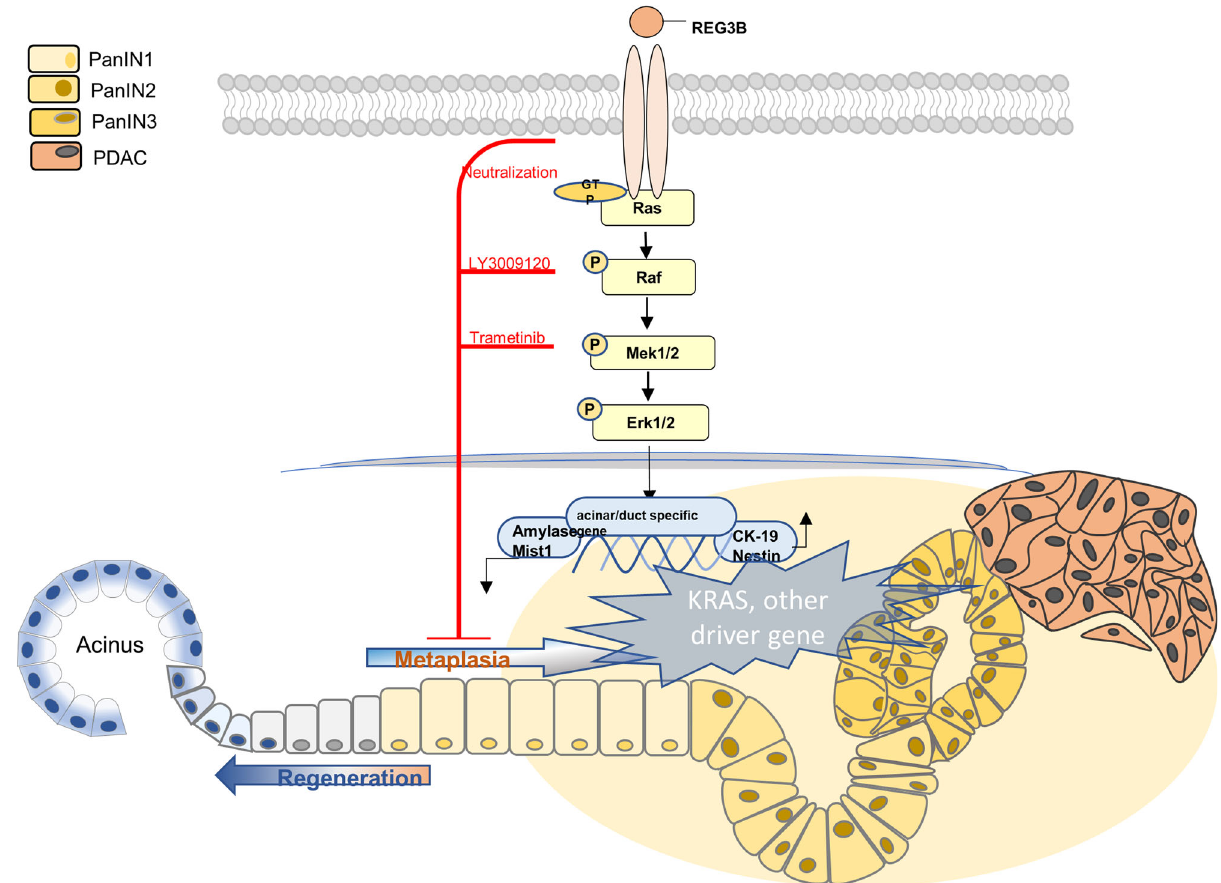
Fig. 8 Schematic illustration of the molecular mechanism of REG3B/REG3A-driven ADM. REG3B/REG3A binds to its receptor, EXTL3 receptor on the acinar cell membrane, and promotes ADM by activating the downstream RAS-RAF-MEK-ERK signaling pathway, in the absence of oncogenic Kras mutation. Targeting REG3B/REG3A, neutralizing its receptor EXTL3, or inhibiting downstream signaling molecules, such as B-RAF (LY3009120) or MEK1/2 (Trametinib), could interrupt the ADM process and potentially prevent early PDAC from fi fteen 20× fi elds on the EVOS microscope (Thermo Fisher Scienti fi c) and bright fi eld images were recorded. Histology, histochemistry, immunohistochemistry, and immuno fl uorescence . Formalin fi xed tissue was processed, embedded in paraf fi n, and cut into 5µm sections. Hematoxylin and Eosin (H&E) (Thermo Fisher Scienti fi c, 7221, 7111) staining was performed according to the clinical laboratory standard. Immuno- histochemistry (IHC) was performed using primary antibodies against REG3A (1:150, R&D Systems, MAB5965), Amylase (1:100, Cell signaling technology) and CK19 (1:100, DSHB). Immuno fl uorescence staining was performed using primary antibodies against CK19 (1:100, DSHB, TROMAII), Amylase (1:100, Cell signaling technology, 3796S), REG3B (1:100, R&D Systems, AF5110 or AF1996) and EXTL3 (1:70, Biotech, NBP1-31645) according to the manufacturers ’ instructions. Western blotting . Proteins were extracted, fractionated by SDS-PAGE, and transferred to nitrocellulose membrane (Bio-Rad). Blots were blocked, incubated with primary antibodies (1:1000) at 4 °C overnight, then washed and incubated with secondary antibodies (HRP-conjugated goat anti-mouse, anti-rabbit, and rabbit anti-goat IgG were used, depending on the primary antibodies used). The membranes were brie fl y incubated with ECL detection reagent (Bio-Rad) to visualize the proteins and images were then captured by ImageQuant Las4000 (GE Healthcare Bio-Science). The primary antibodies were: p-BRAF (T401,Abcam, ab68215), BRAF (Cell Signaling Technology, 14814S), p-MEKk1/2 (Cell Signaling Technology, 9154S), MEK1/2 (Cell Signaling Technology, 4694S), p-ERK1/2 (Cell Signaling Technology,T202/Y204, 4370S), ERK1/2 (Cell Signaling Technology, 5013S), GAPDH (Invitrogen, MA5-15738), REG3B (R&D Systems, AF5110,